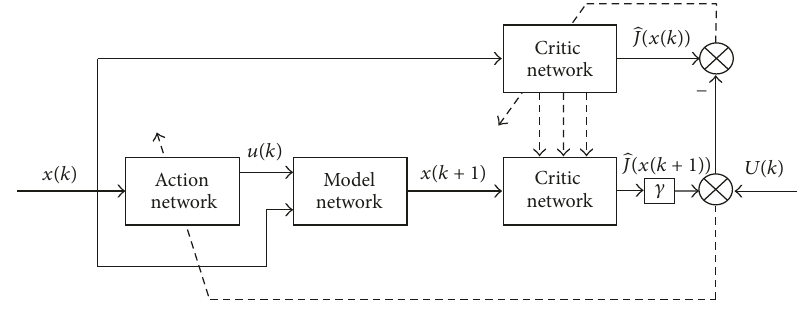
Figure 4: An overview of the HDP